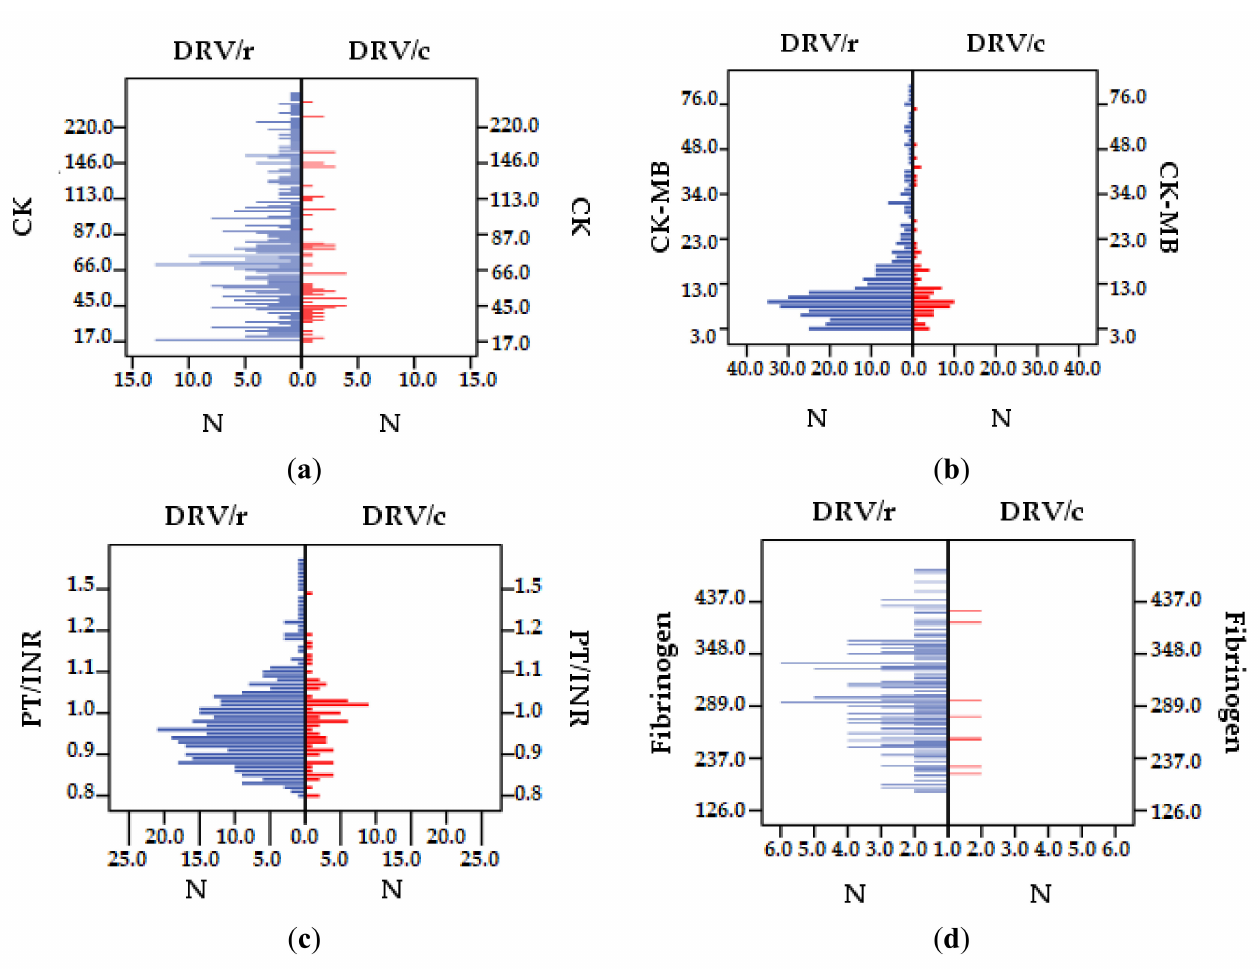
Figure 5. Difference between DRV/r and DRV/c as cardiac and coagulation markers: ( a ) CK (IU/L), ( b ) CK-MB (IU/L), ( c ) PT/INR, ( d ) fibrinogen